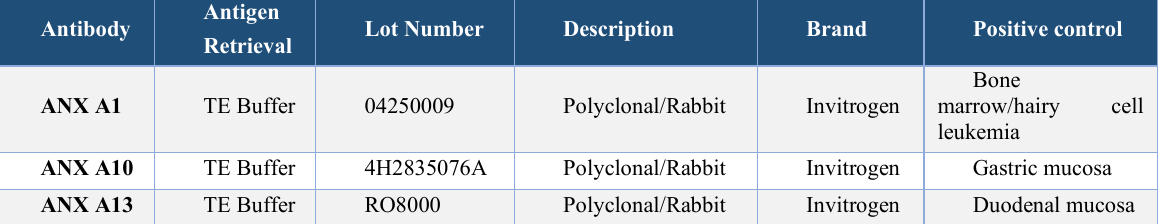
Table 1. Characteristics of Annexin Antibodies which have been used to differentiate CC and PDA in the liver (ANXA1, ANXA10, and ANXA13)